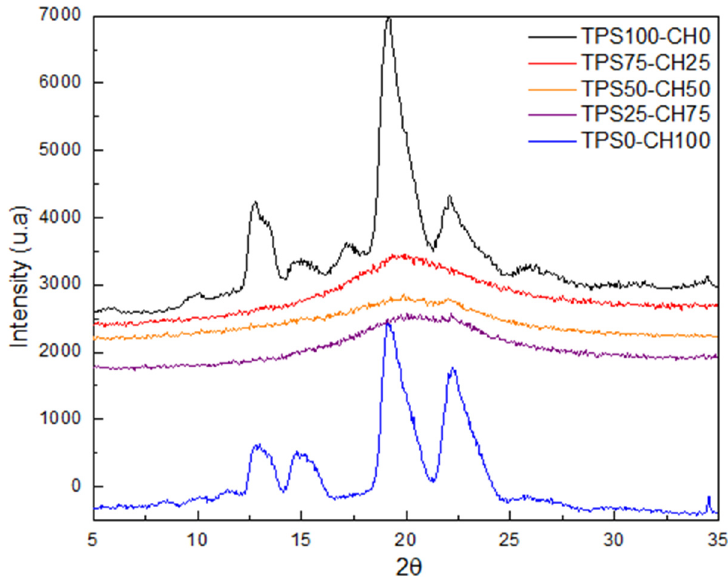
Figure 3. X-ray diffraction ( XRD) diffractograms of starch:chitosan (TPS:CH) films.